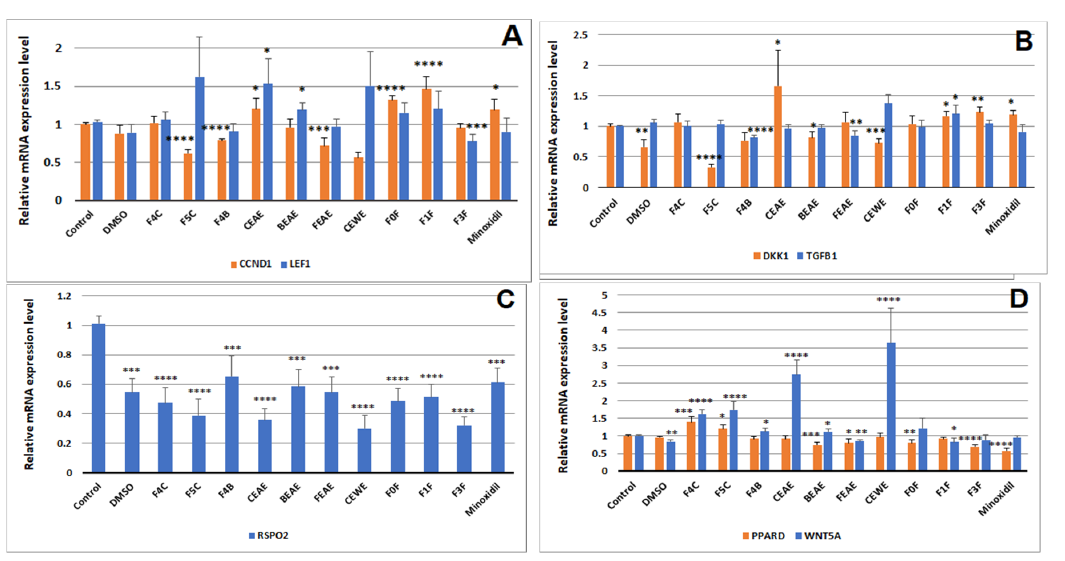
Figure 8. Relative mRNA expression levels of cyclin D1 and LEF1 ( A ), DKK1 and TGF β 1 ( B ), RSPO2 ( C ) and PPARD and WNT5A ( D ) compared to the control. Tested concentrations are 50 µ g mL − 1 for FEAE-F0, FEAE-F3 and FEAE, 25 µ g mL − 1 for CEWE, FEAE-F1, CEAE-F4 and CEAE-F5, 12.5 µ g mL − 1 for BEAE, CEAE and BEAE-F4. Significance is determined by * p < 0.05 , ** p < 0.01 , *** p < 0.001 and **** p < 0.0001 using a Student’s t -test.